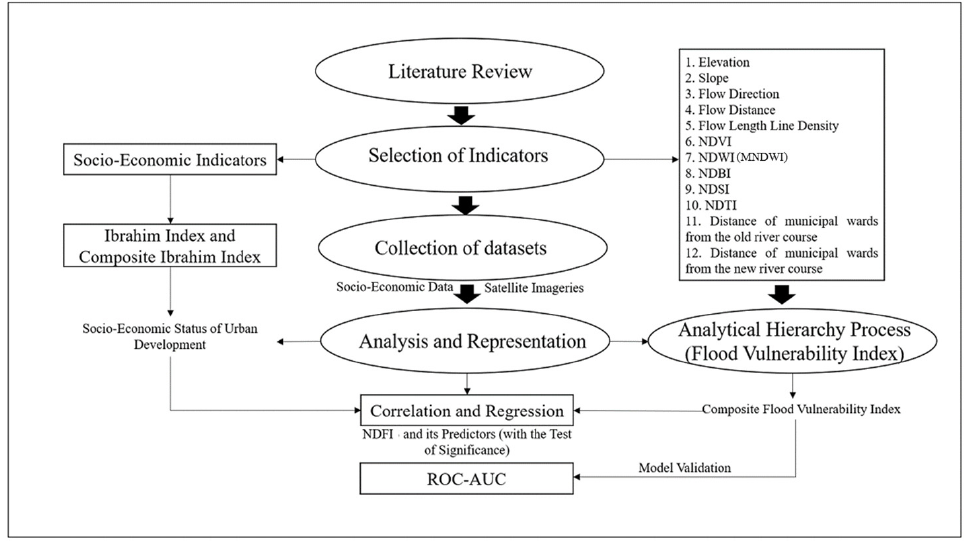
Figure 2. A general methodological framework of the present study.